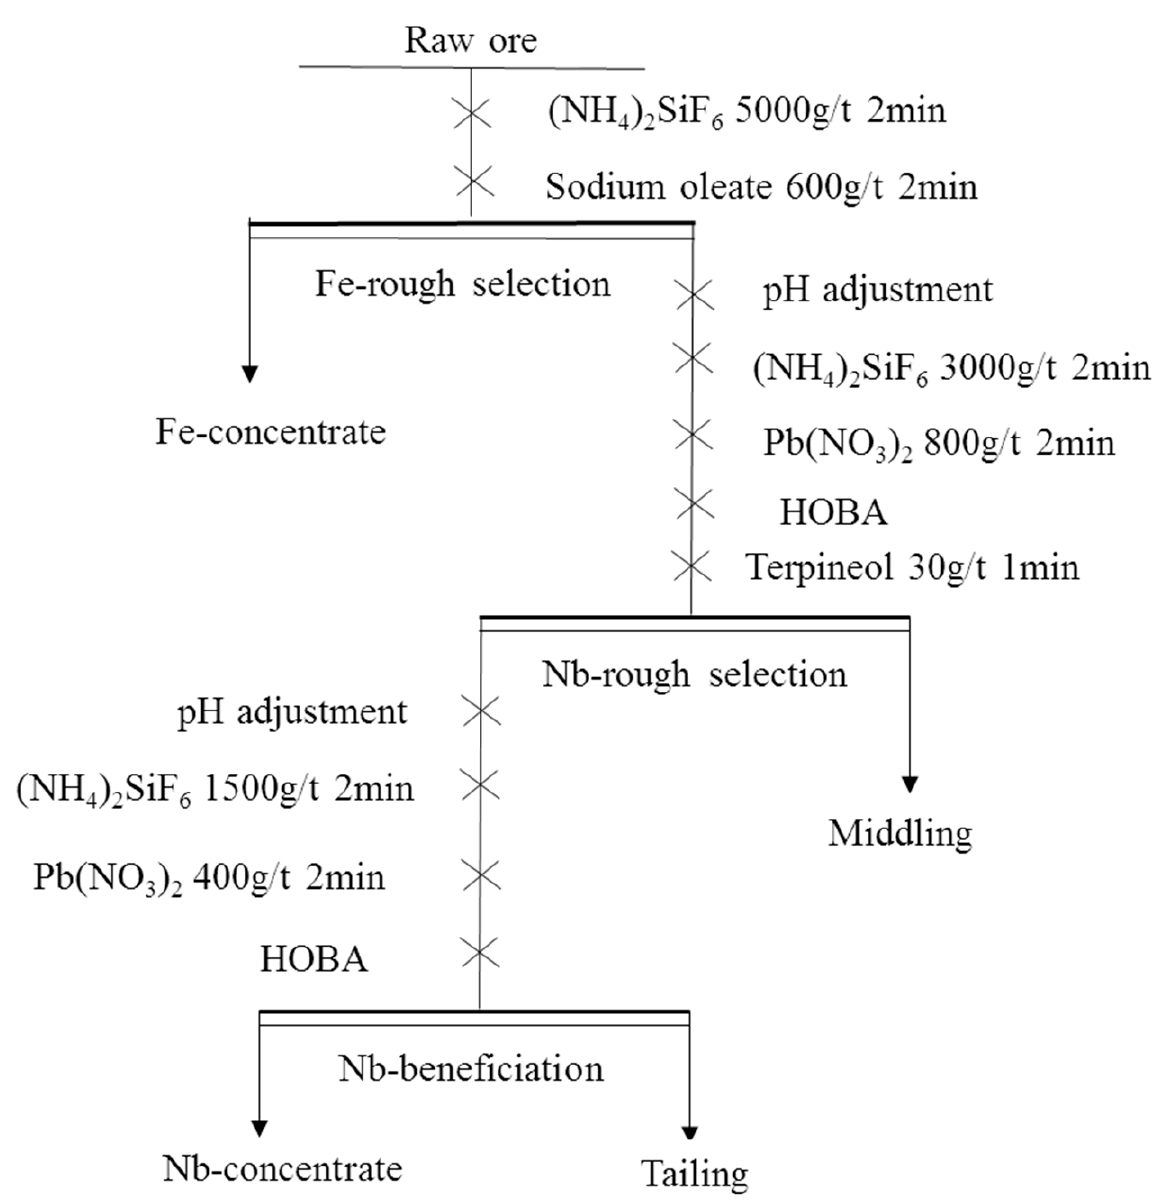
Figure 1. The flowsheet of the flotation of niobium-containing minerals.